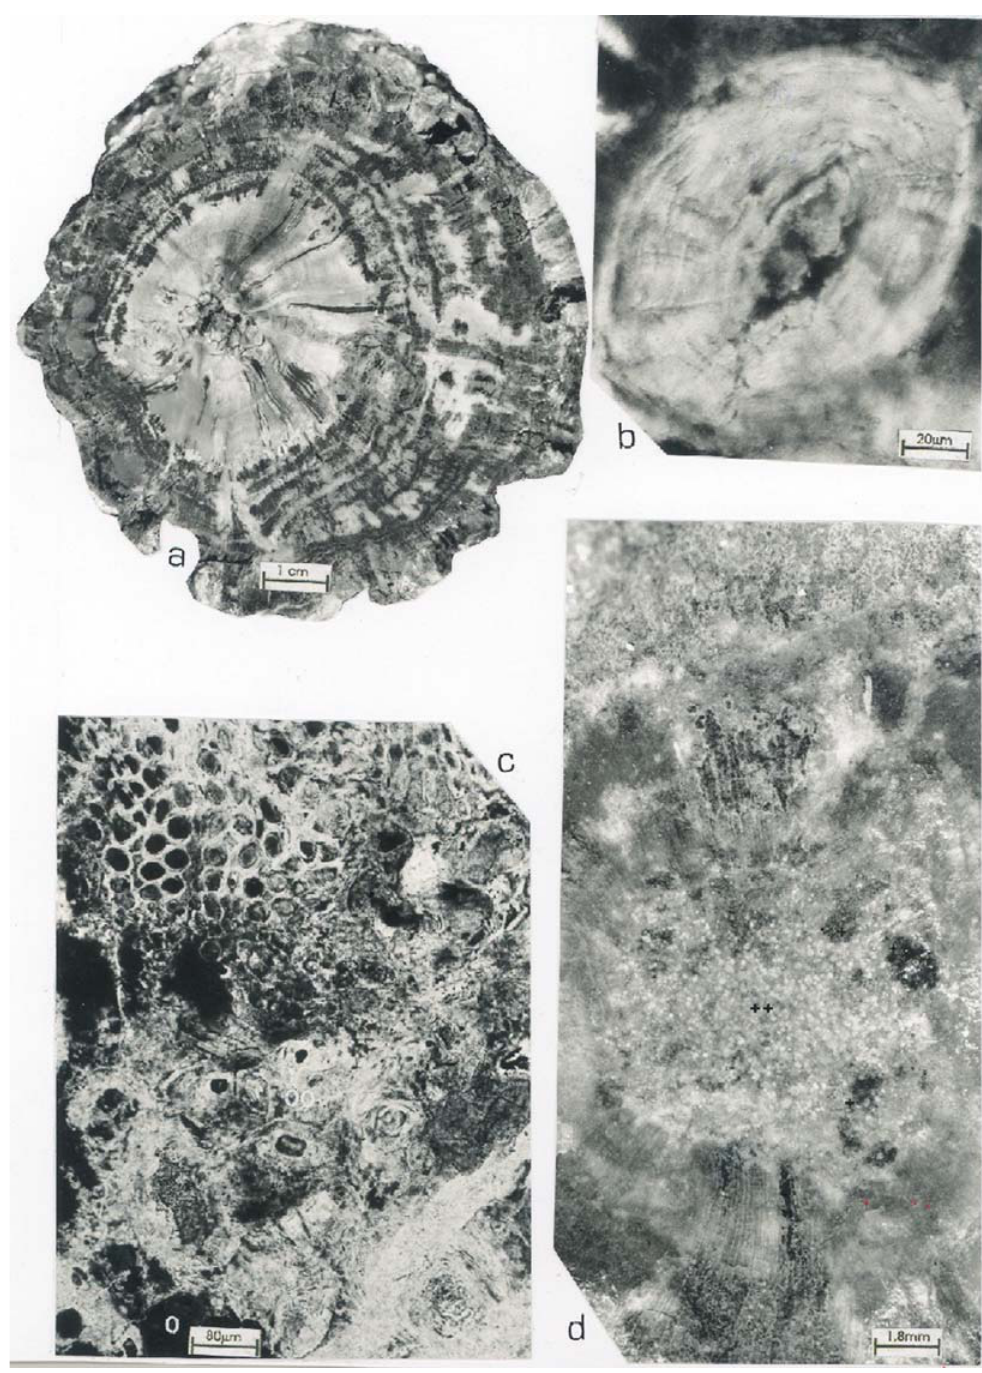
Fig. 1 – Sommerxylon spiralosus n.gen. et n.sp. Transverse section a: distinct growth rings, represented by clear and dark bands – Pb 278. b: Sclerenchymatous thick walled cell, heavy pitted. c: primary xylem endarch, wedge shaped, outlying the periphery of the pith, nest of sclerenchymatous cells irregularly gaps. d: solid pith heterocelular – PB 3782.